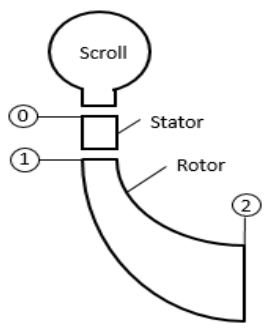
Figure 9. Turbine general